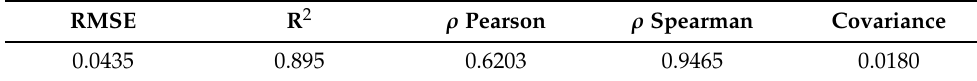
Table 6. Statistical fit and correlation